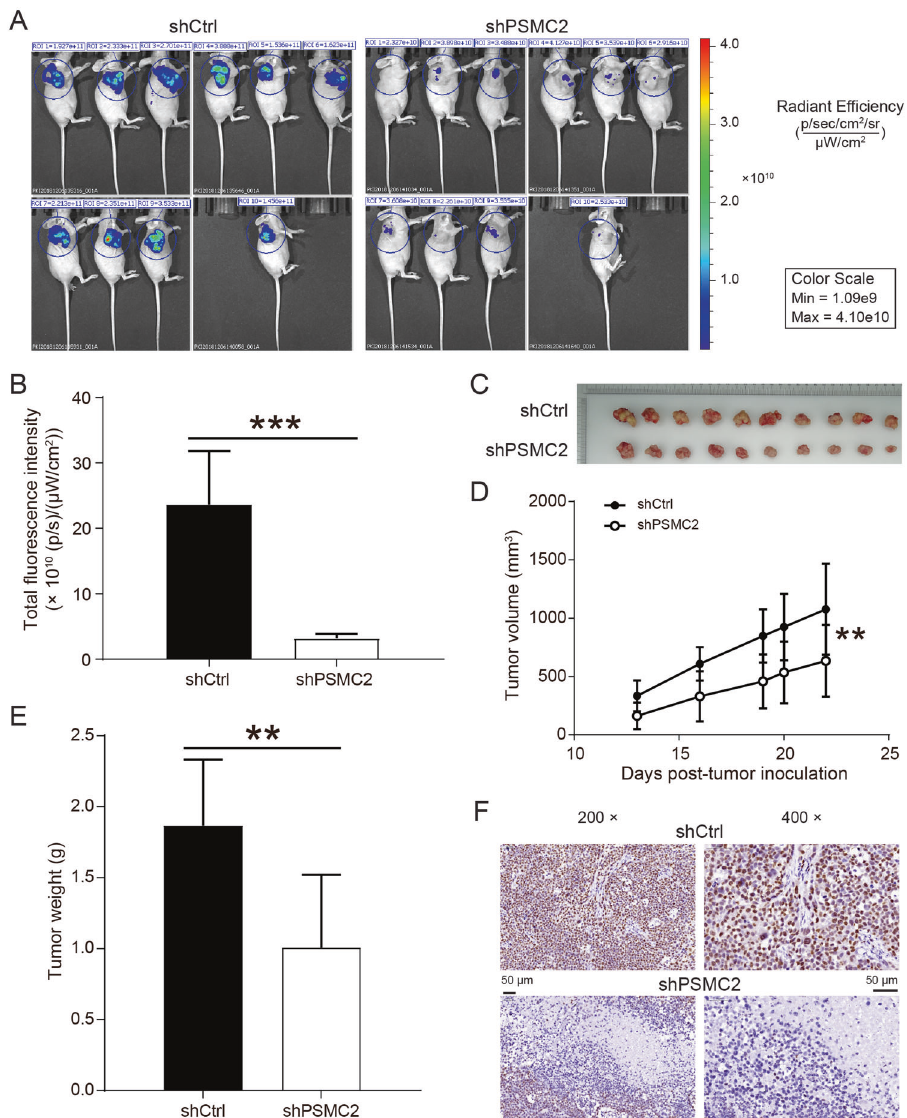
Fig. 2 PSMC2 knockdown suppressed the growth of tumor in vivo. A Representative images of in vivo imaging. B The fl uorescence intensity of nude mice in the PSMC3 knockdown group and control group was detected. C Pictures of solid tumors taken out of nude mice. D The tumor volume growth rate of nude mice in the PSMC2 knockdown group was smaller than that in the control group. E The tumor weight of nude mice in the PSMC2 knockdown group was lower than that in the control group. F The immumohistochemical staining was performed to detect the Ki67 expression in the tumor tissues. ** P < 0.01; *** P < 0.001, compared with shCtrl group. Error bars meant